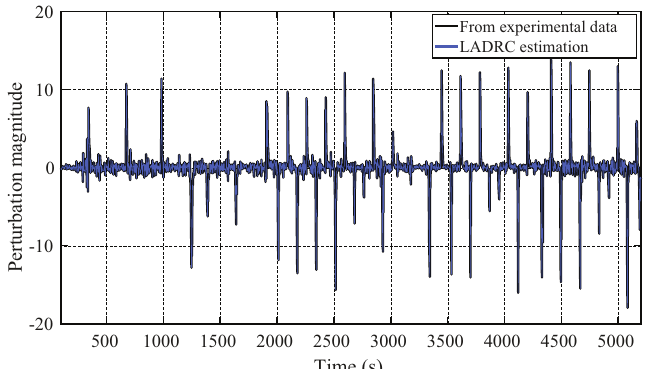
Figure 19. Disturbances caused by the turbojet change the operating thermal state, f d ( P 4 , T 4 , ˙ m t )